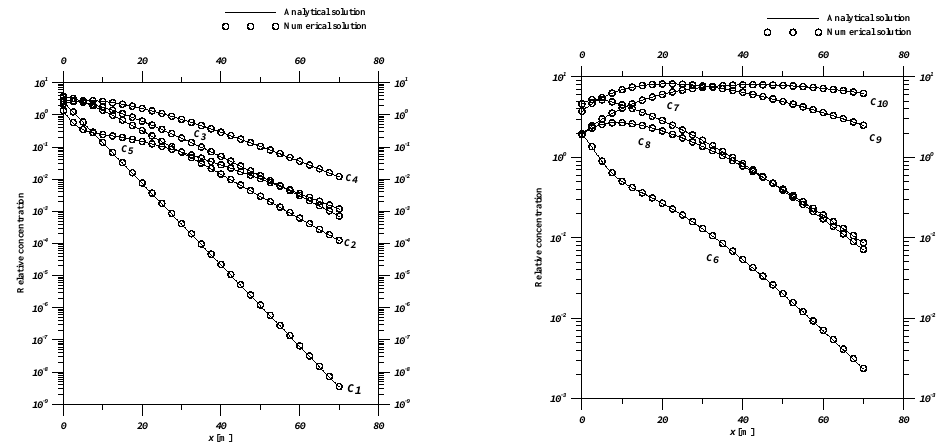
Fig. 8 Figure 8. Comparison of spatial concentration profiles of ten-species along x direction at t = 20days obtained from derived analytical solutions and numerical solutions for the test example 3 of ten species decay chain used by Srinivasan and Clement